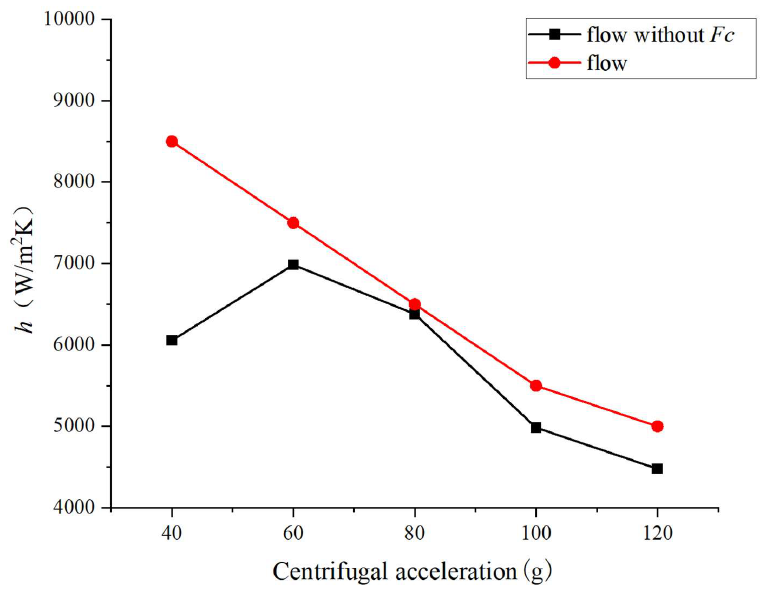
Figure 21. Heat transfer coefficient under the influence of Coriolis force.